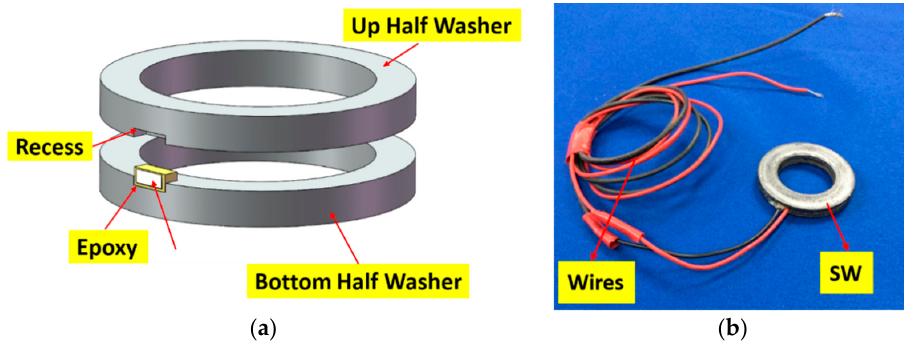
Figure 26. ( a ) The design of the smart washer; ( b ) Photograph of the smart washer [74].